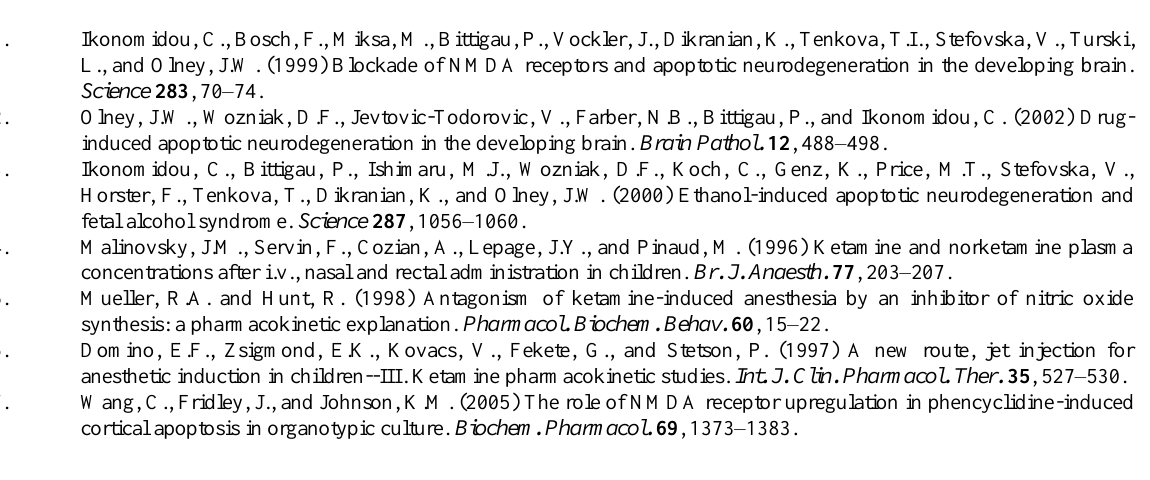
or recommendation for use. The findings and conclusions in this report are those of the authors and do not necessarily represent the views of the